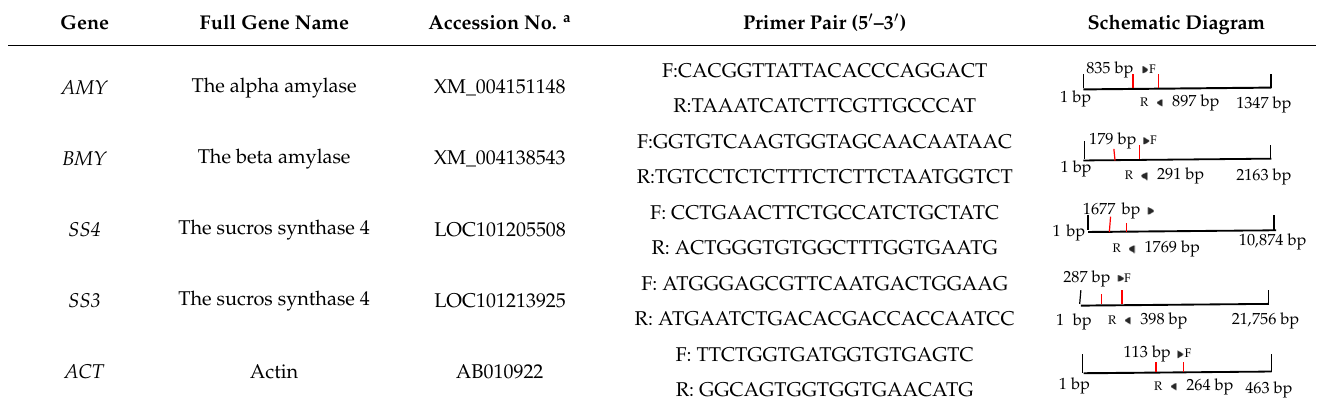
Table 2. Primers used for relative quantitative real-time PCR assays.